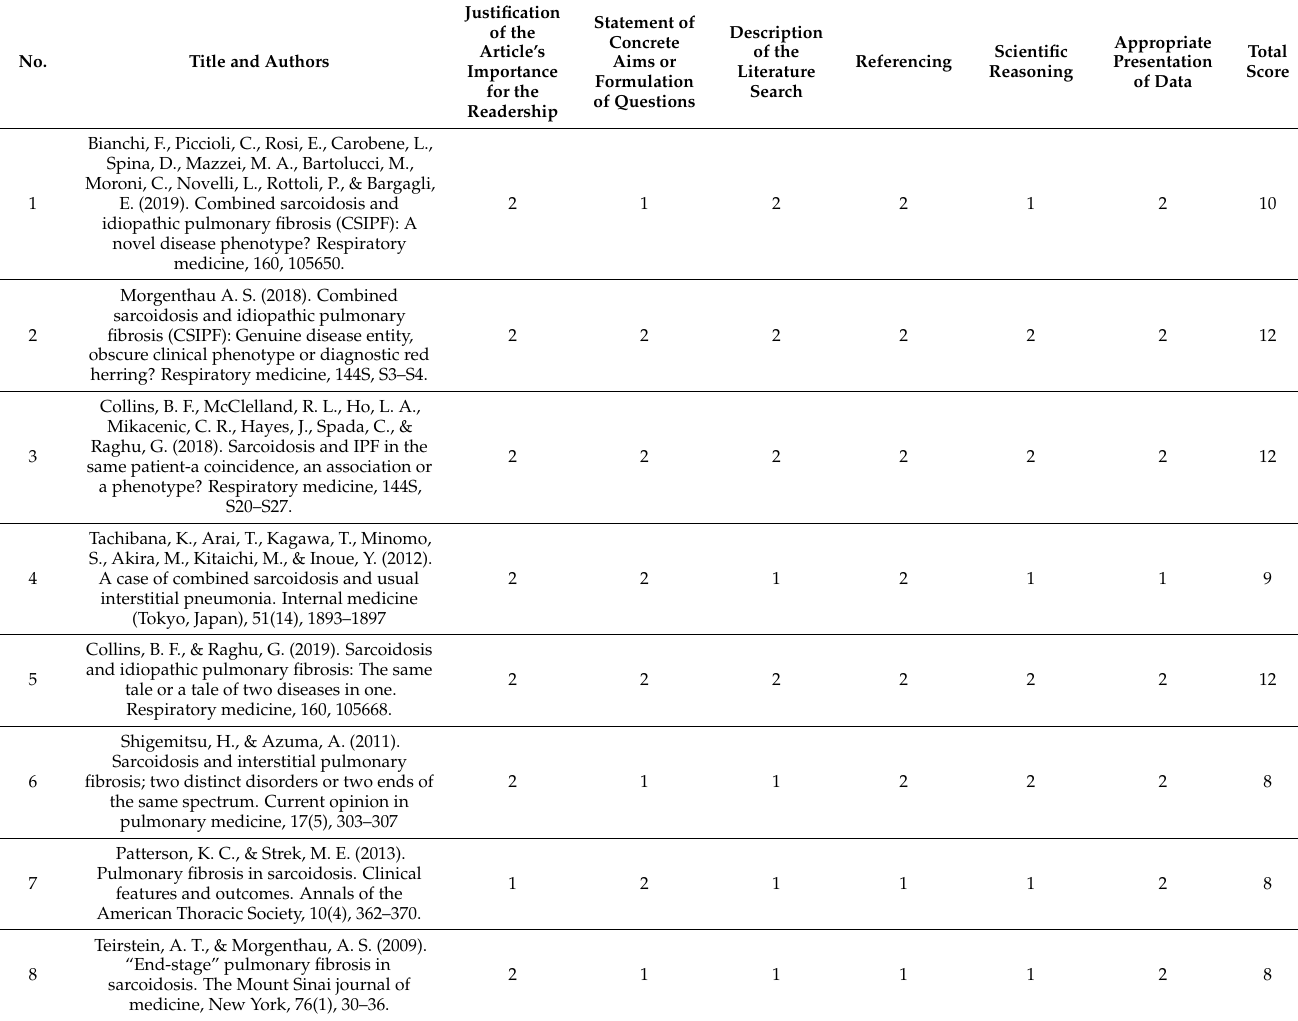
Table 1. SANRA Quality assessment of selected